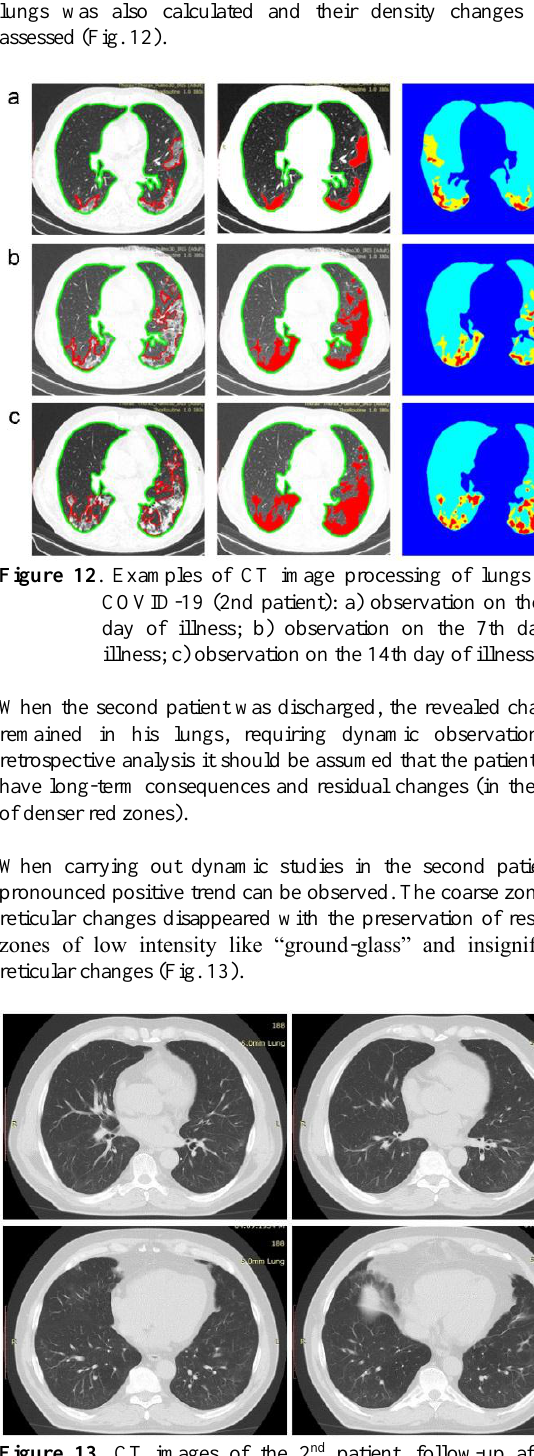
Table 1. Assessment of the definition of indicators and